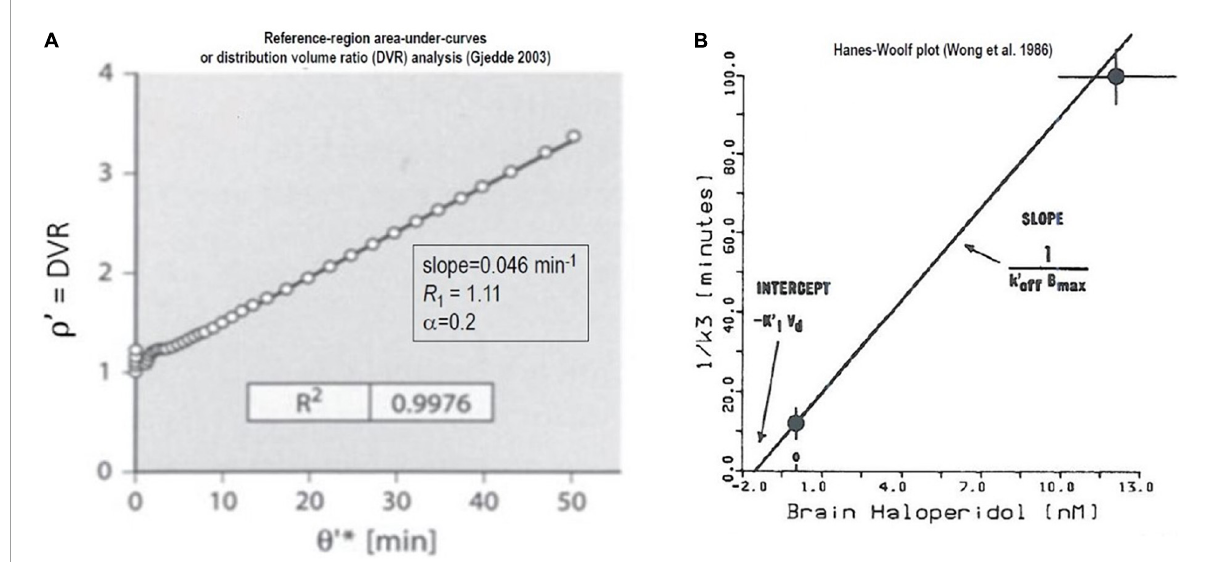
FIGURE7 Non-saturable binding relative to reference region: Irreversible binding of [ 11 C]NMSP. Graphical plots of an irreversibly binding radiotracer with a reference region. (A) Shows Distribution Volume Ratio (DVR) relative to cerebellum of [ 11 C]NMSP binding in human striatum vs. time variable θ (cid:48) (Gjedde, 2003). (B) Hanes-Woolf plot of time constants of binding as function of inhibitor concentration (Wong et al.,